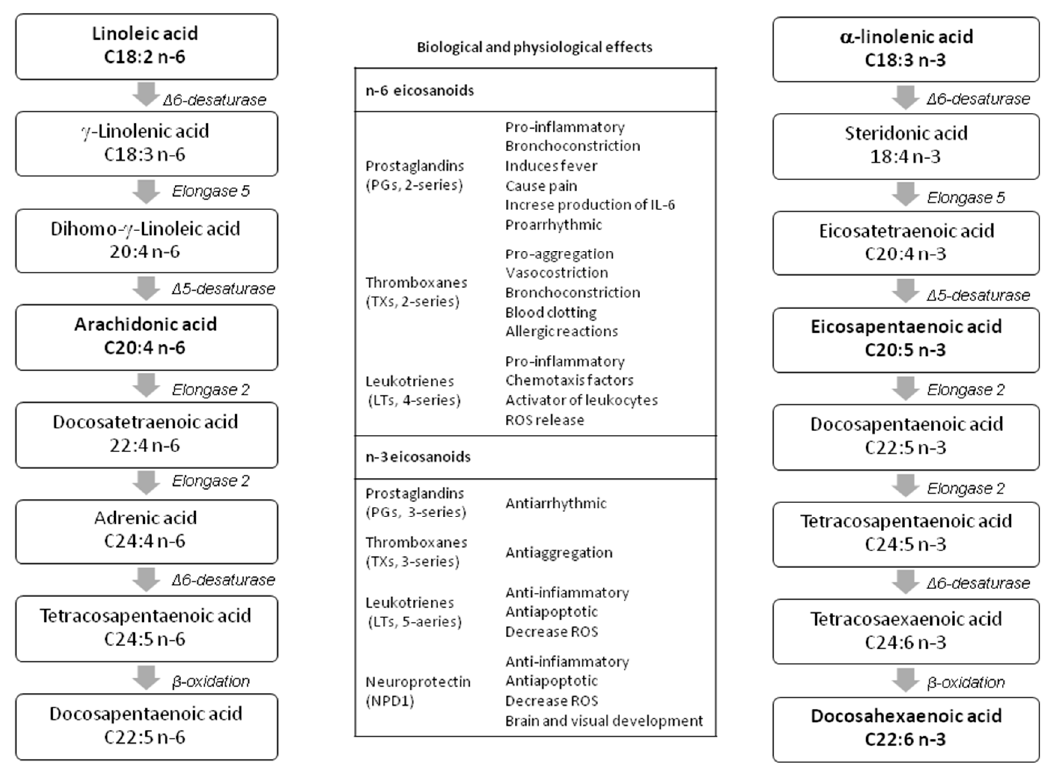
Figure 1. Long-chain polyunsaturated fatty acid (LC-PUFA) n-3 and n-6 biosynthetic pathways and physiological effects of their eicosanoid derivatives (modified by Patterson et al. [21]).